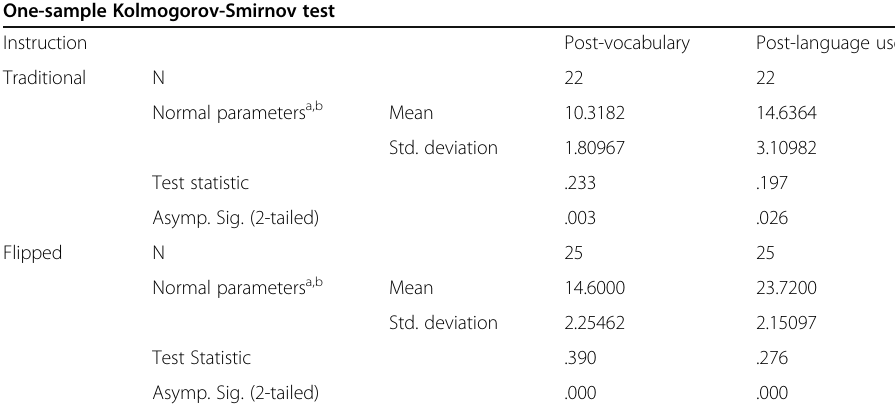
Table 11 Normality test (post-vocabulary and post-language use) One-sample Kolmogorov-Smirnov